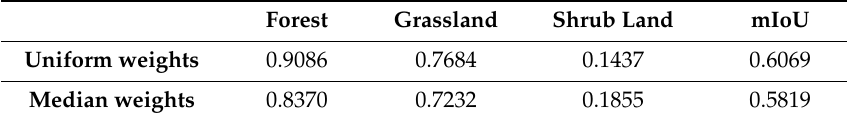
Table 10. IoU (uniform and median weights, Slovenia—3 classes).